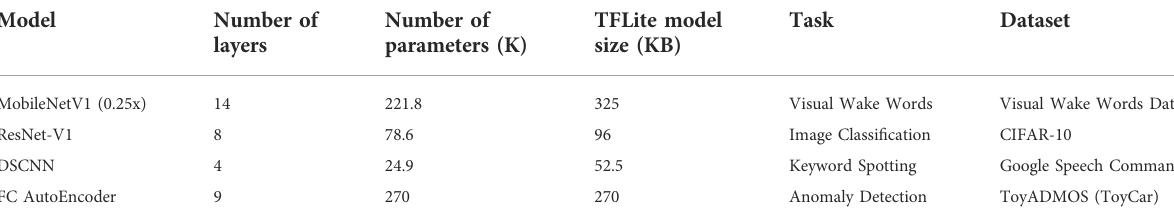
TABLE 1 Quantitative description of MLPerf Tiny benchmark (Banbury et al. (2021)) models depicting the scale of neural network models used in tinyML applications.